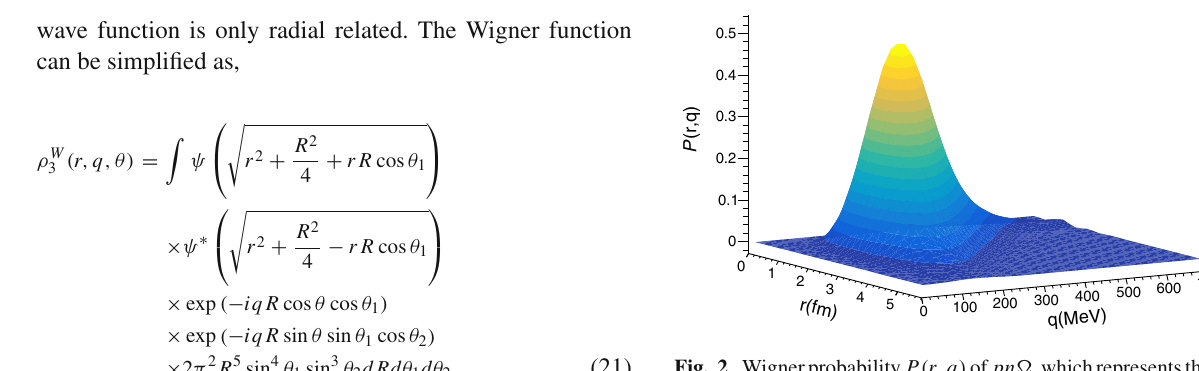
Fig. 2 Wignerprobability P ( r , q ) of pn (cid:3) ,whichrepresentstheproba- bilitytofind the pn (cid:3) ground bound stateatbinding energy 21.7 MeVat six-dimensional hyperspherical radius r and at six-dimensional hyper- spherical momentum